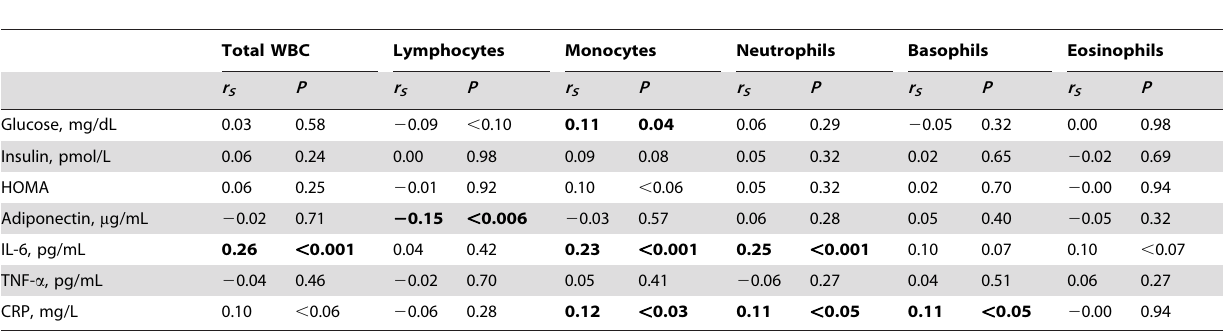
Table 5. Spearman correlation coefficients (r S ) between change in total WBC and WBC subfraction counts (cells/ m L) and changes in fasting glucose metabolism and inflammation after 6 months of